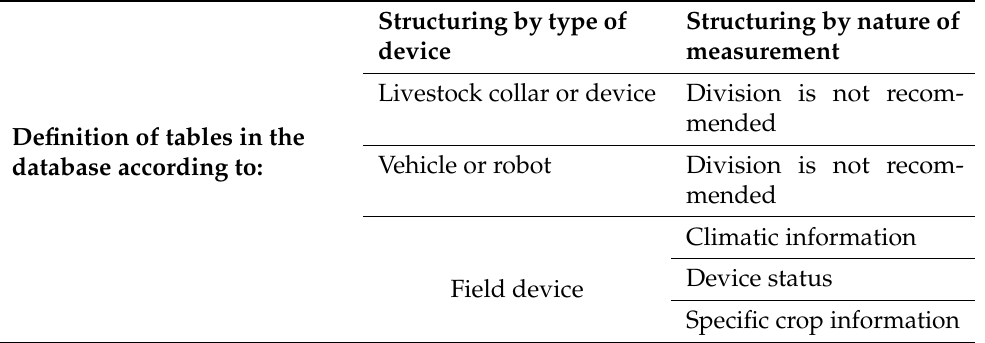
Table 8. Structure of the database in